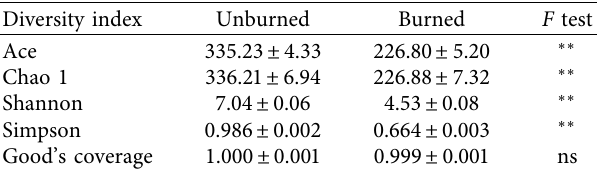
Figure 3: Relative abundance of major bacteria by (a) phylum and (b) genus from soil samples of unburned and burned sugarcane plots. Table 2: Soil bacterial diversity indices and richness estimates of unburned and burned sugarcane harvest determined using Illu- mina MiSeq sequencing